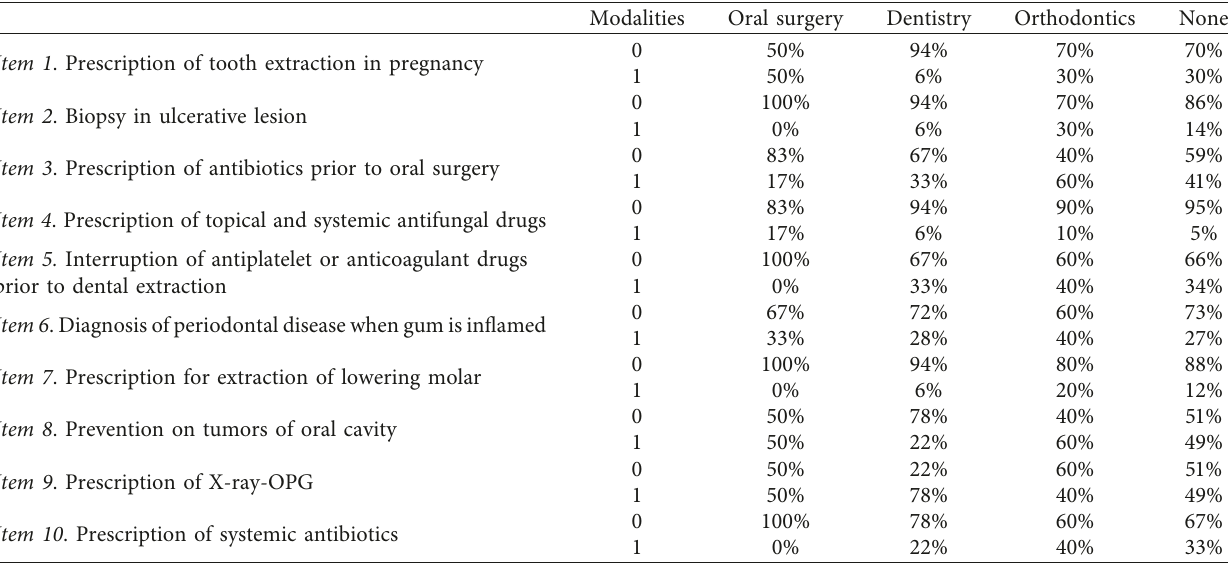
Table 4: Frequency distribution of number of errors for different kind of